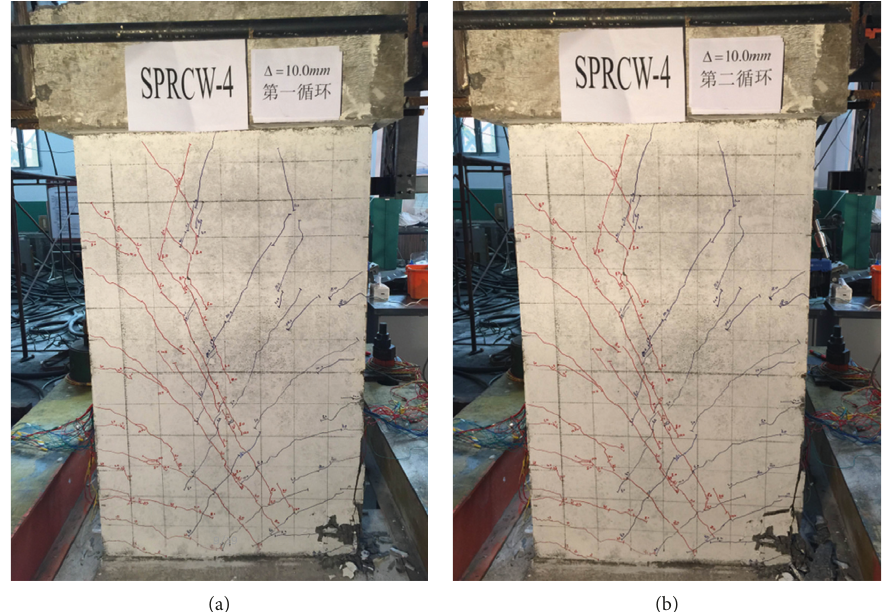
Figure 21: Diagram of cracks in the Δ � 10mm displacement cycle. (a) First cycle. (b) Second cycle.